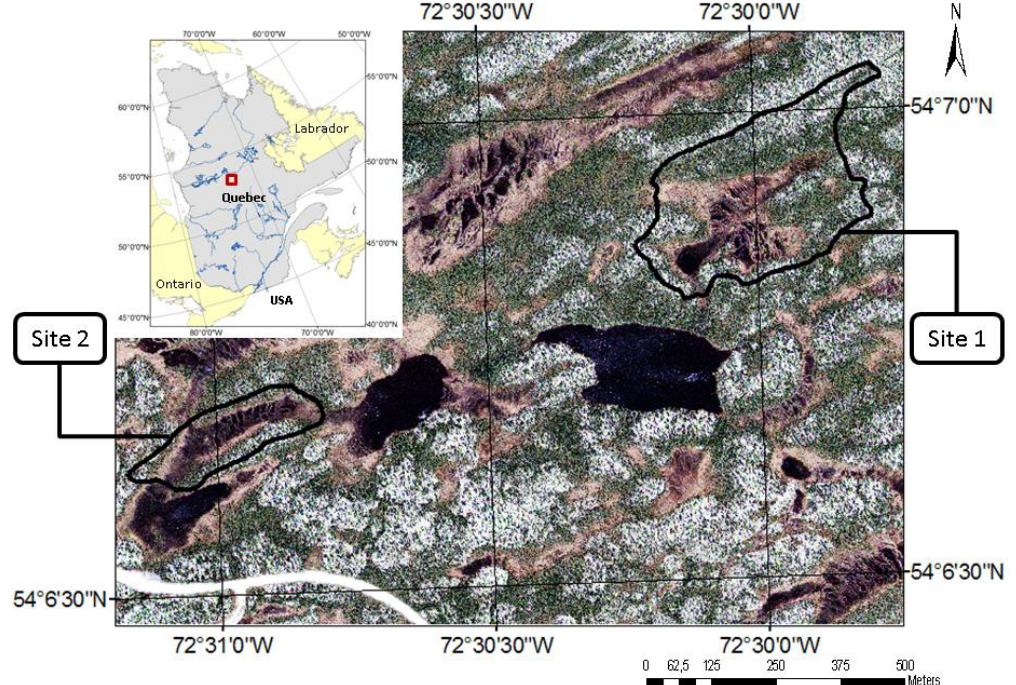
Figure 1. Location map of the two study site watersheds in the James Bay region, Quebec,